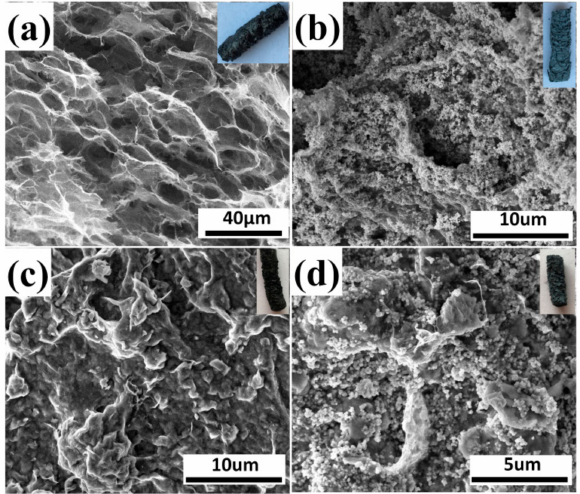
Figure 5. SEM images of ( a ) GO, ( b ) 10% GO / TiO 2 , ( c ) 10% GO / Bent, and ( d ) 10% GO / TiO 2 / Bent. Insets are pictures of macroscopic columnar